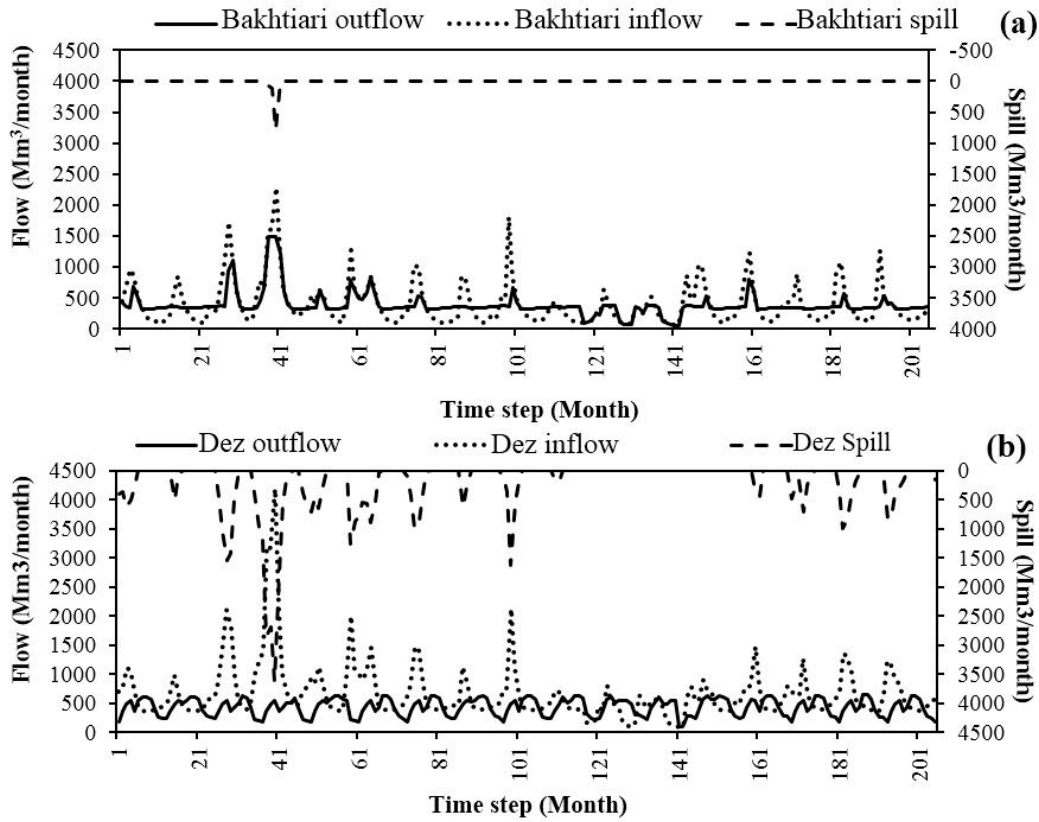
Figure 11. The monthly inflows, outflows, spills, and reservoir storages for the base period; ( a ): inflow, outflow, and spill of the Bakhtiari reservoir; ( b ): inflow, outflow, and spill of the Dez